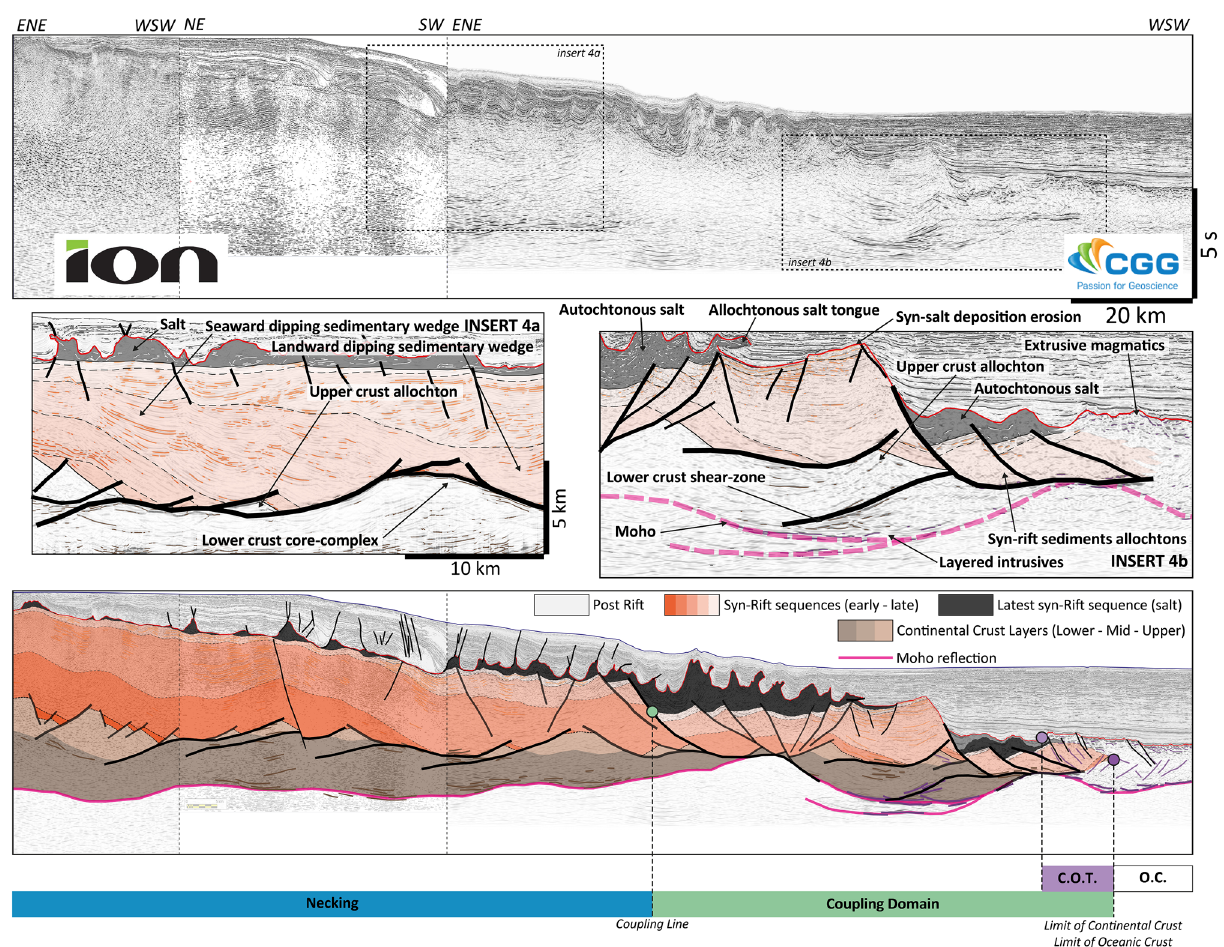
Figure 4. South Gabon case study. The section is characterized by a very long necking domain with a primary necking and a long low angle wedge toward the distal domain. The thinning of the crust is accommodated on